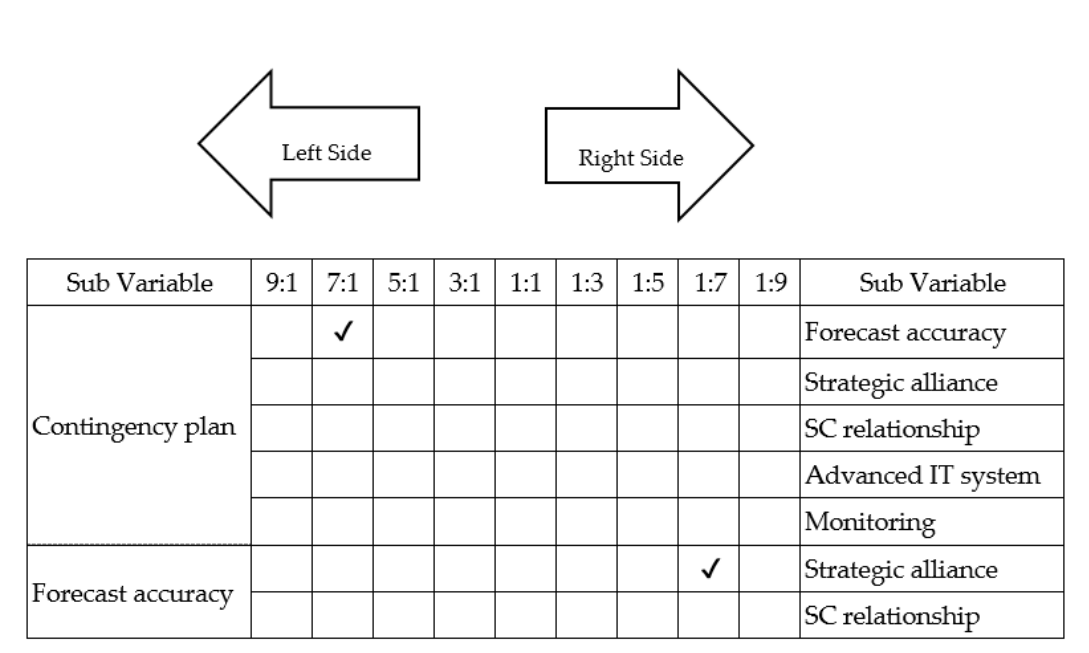
Figure 5. An example of filling in the analytical hierarchy process ( AHP) score column.